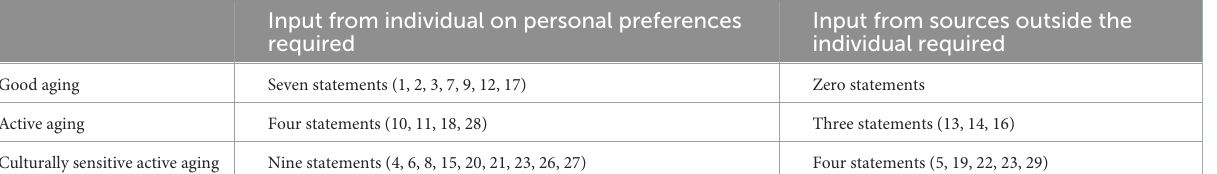
TABLE 4 The advancing need for external information as complexity of care interventions increase. Input from individual on personal preferences